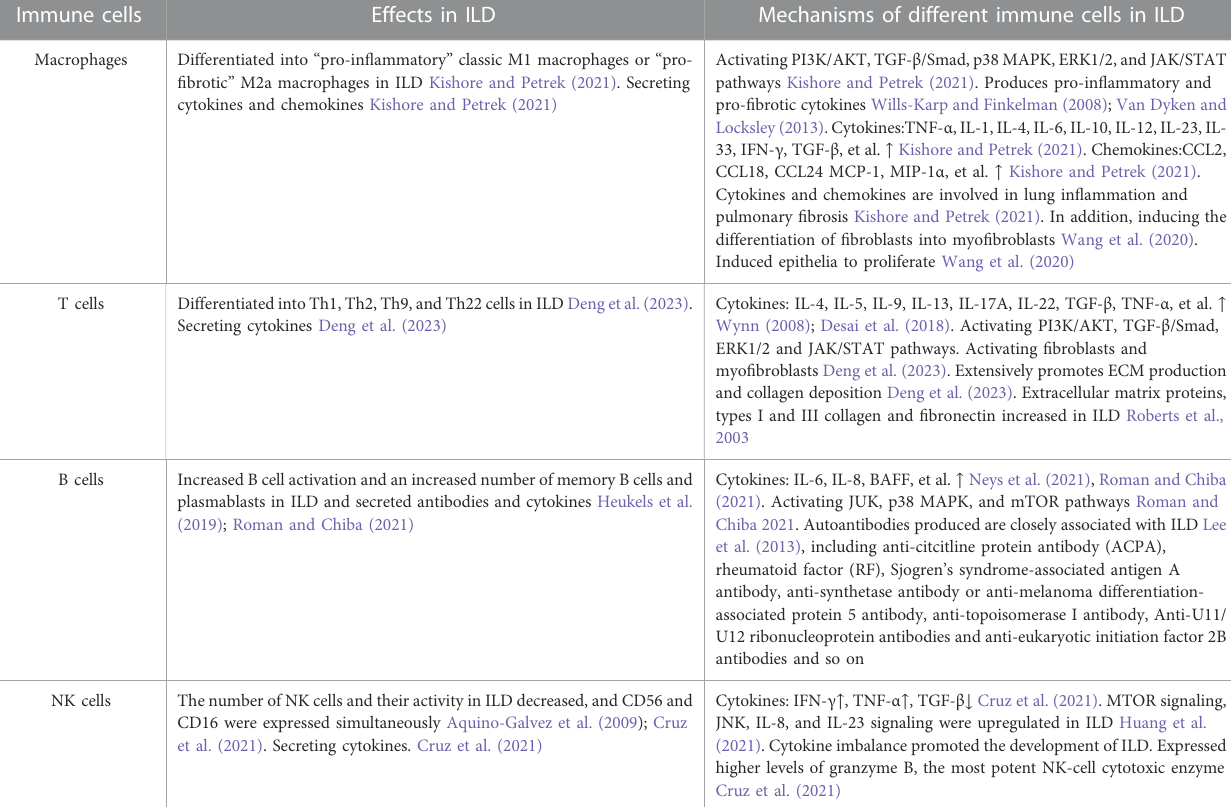
TABLE 1 Mechanism of different immune cells in ILD. Immune